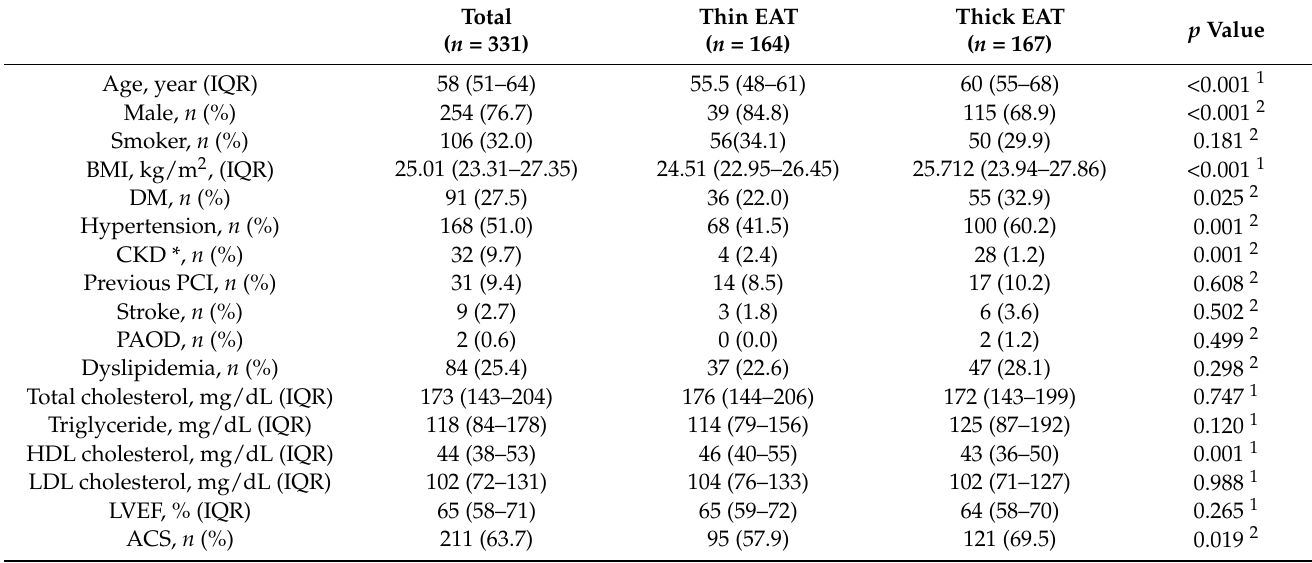
Table 1. Patient characteristics of this study.